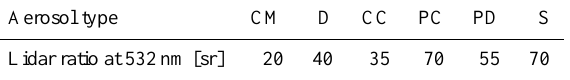
Table 2. CALIPSO aerosol subtypes and the associated lidar ratio at 532nm used in the aerosol optical properties retrieval. CM stands for clean marine, D for dust, CC for clean continental, PC for pol- luted continental, PD for polluted dust, and S for